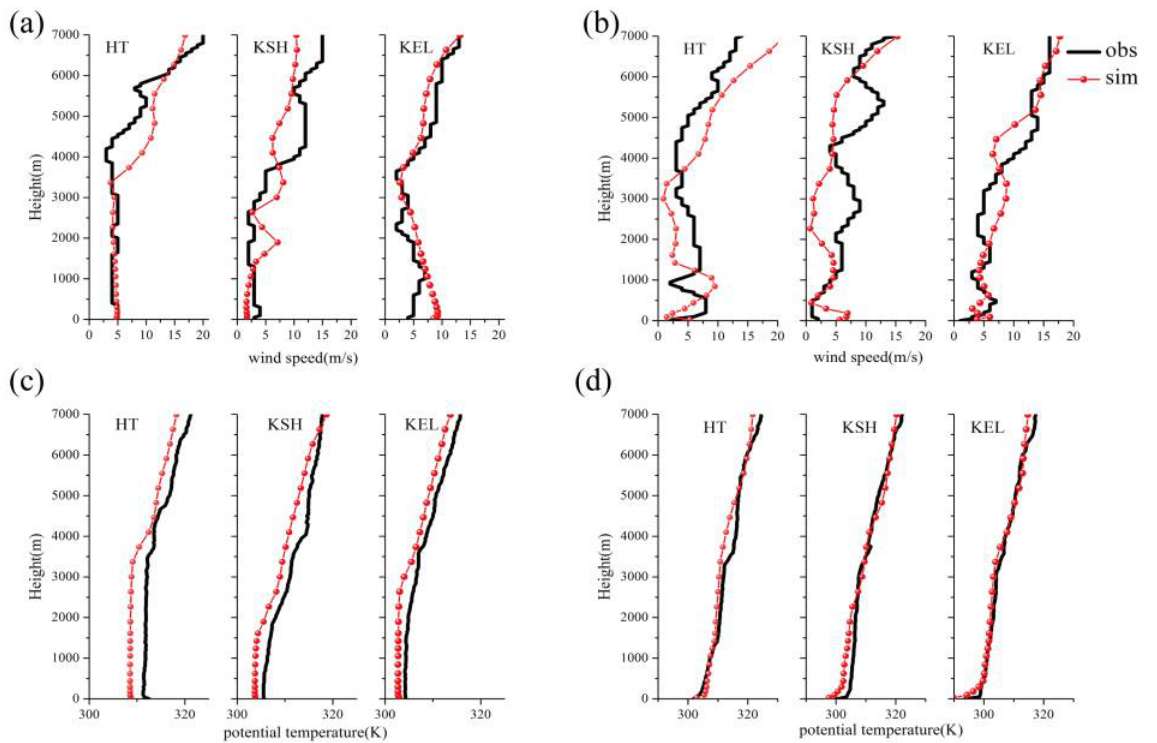
Figure 3. Vertical profiles of the ( a , c ) wind speed at the HT, KEL, and KSH stations on 29 April 2015, at 11:00 UTC, and the ( b , d ) potential temperature at the HT, KEL, and KSH stations on 29 April 2015, at 23:00 UTC. Red dotted lines represent simulated values (sim). Black lines represent observed values (obs).